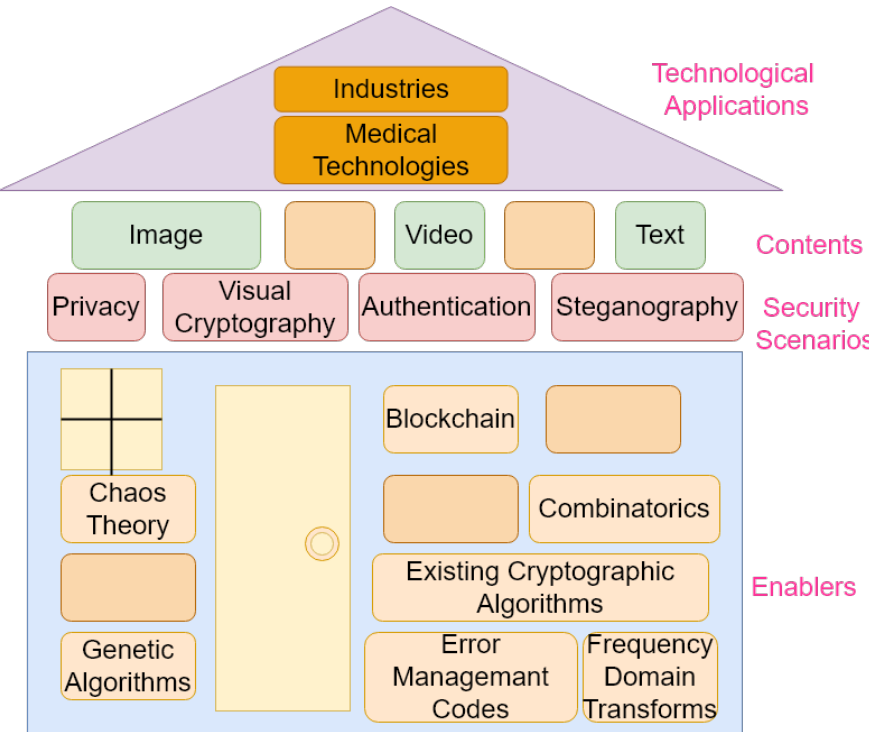
Figure 2. The ecosystem of neural cryptography. NN-Improved